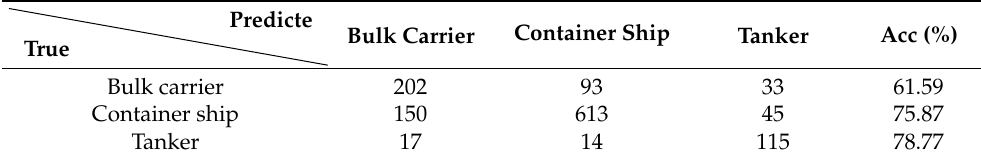
Table 7. Classification confusion matrix of ResNet on the OpenSARShip-1.0 dataset.